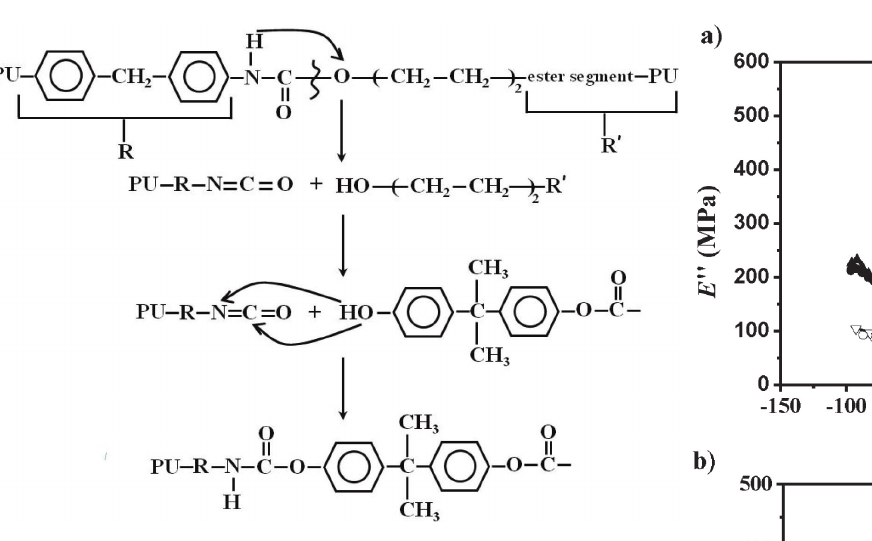
Scheme 4 – Formation of PU/PC copolymer